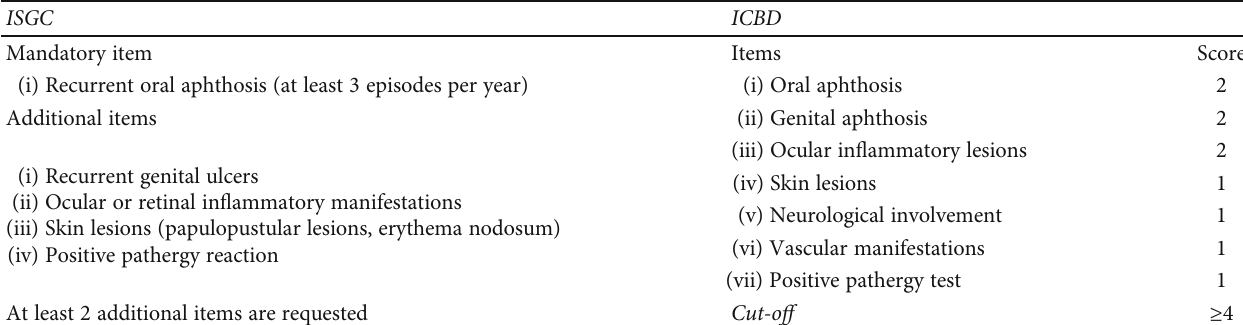
Table 6: Criteria for the diagnosis of Behçet ’ s disease (BD): International Study Group Criteria (ISGC) [152] and International Criteria for BD (ICBD)